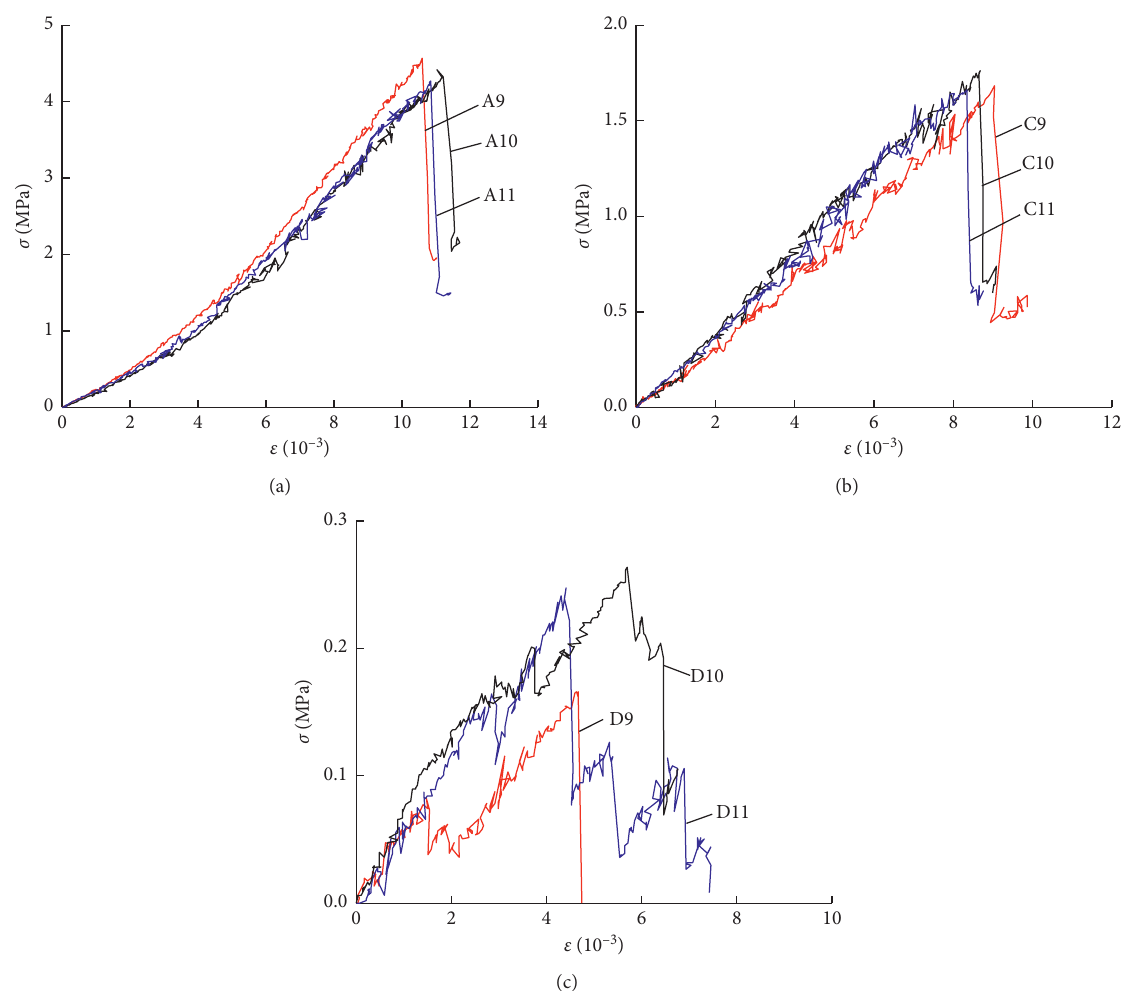
Figure 11: Stress-strain curve of each group of specimens in the Brazilian split test. (a) Natural. (b) Water saturation. (c) High-temperature dehydration at 220 °